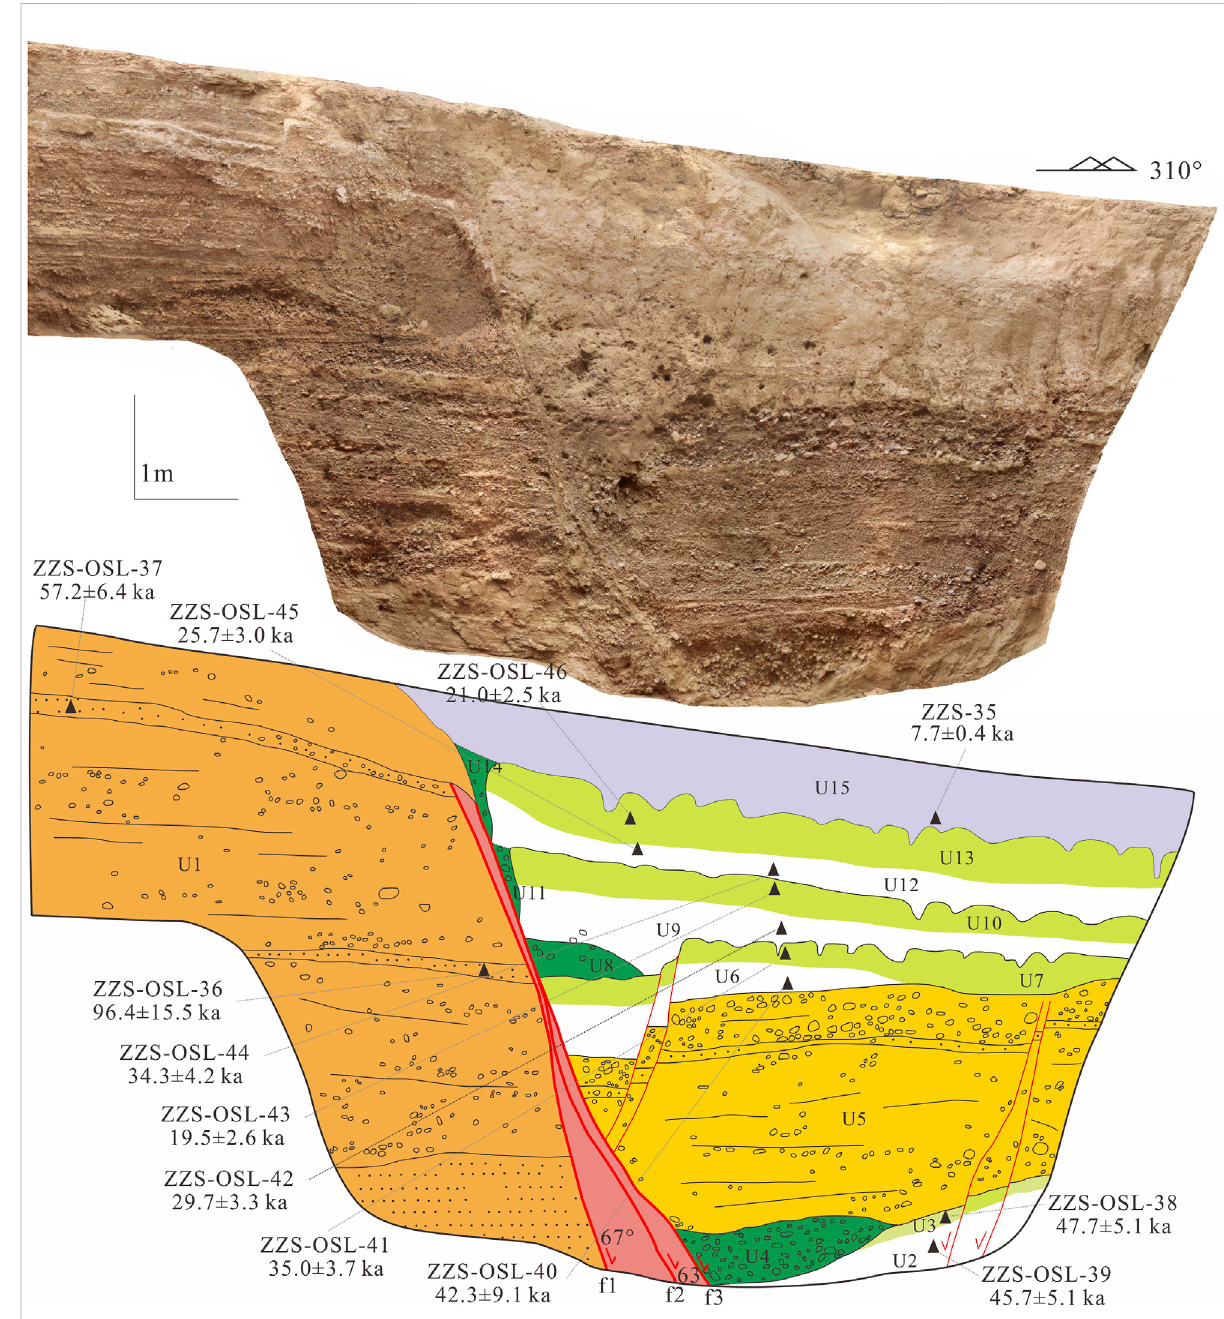
PhotomosaicandcorrespondinglogmapwithactivefaultsandOSLageresultsoftrench1.Themainfaultisrepresentedbythickredlines,while the secondary fault is represented by thin red lines. Strata of the same color represent similar sedimentary characteristics. For example, grass green represents different buried paleosol, and the dark green represents colluvial wedges or fi lling